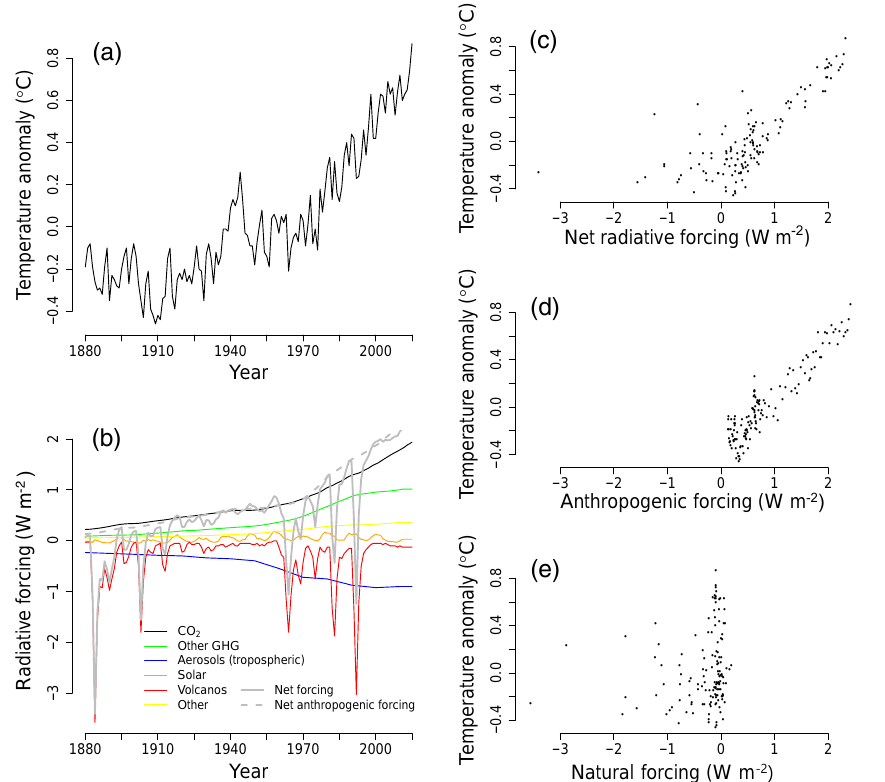
Figure 1. (a) Estimates of annually averaged global mean surface temperature anomalies (relative to a base period of 1951–1980) from the years 1880 to 2015. (b) Estimates of (top-of-atmosphere) effective radiative forcings from different constituents over this time period (the “other” category includes O 3 , H 2 O, black carbon, contrails, and land use changes). Right, temperature anomalies vs. net radiative forcings (c) , vs. anthropogenic forcings (d) , and vs. natural forcings (e) . Data sources are described in Sect. 2. Despite the correlation in the plots of temperature vs. radiative forcing, temperatures will depend on the full past trajectory of radiative forcings in a potentially complex way, as we discuss in Sect.